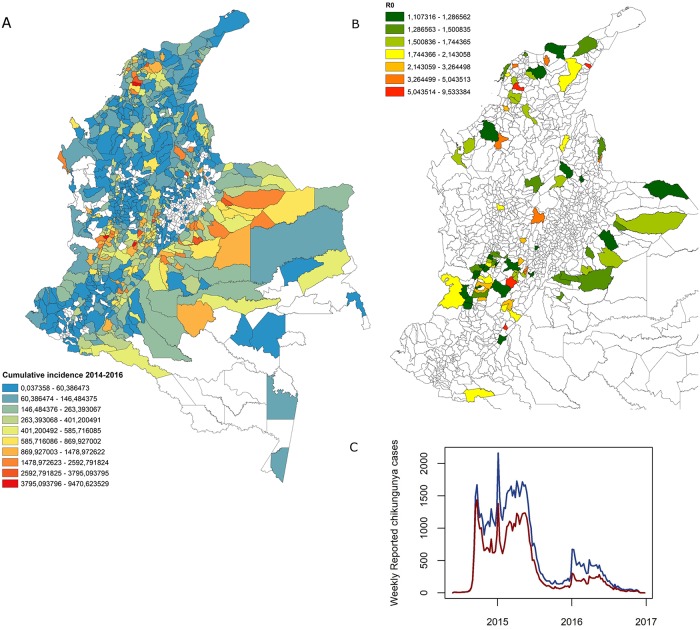
General behavior of the chikungunya epidemic that occurred in Colombia from 2014 to 2016.(A) Cumulative incidence discriminated by municipalities in Colombia according to cases reported through SIVIGILA by INS, (B) R0 estimated for 85 municipalities with epidemic CHIKV in Colombia and their geographical locations, (C) Behavior in time of the total reported cases in Colombia (blue line) and the reported cases of the 85 municipalities chosen to estimate R0 (red line). All maps were generated using ArcGIS 10.4.1 for this publication by the authors and has not been published elsewhere.